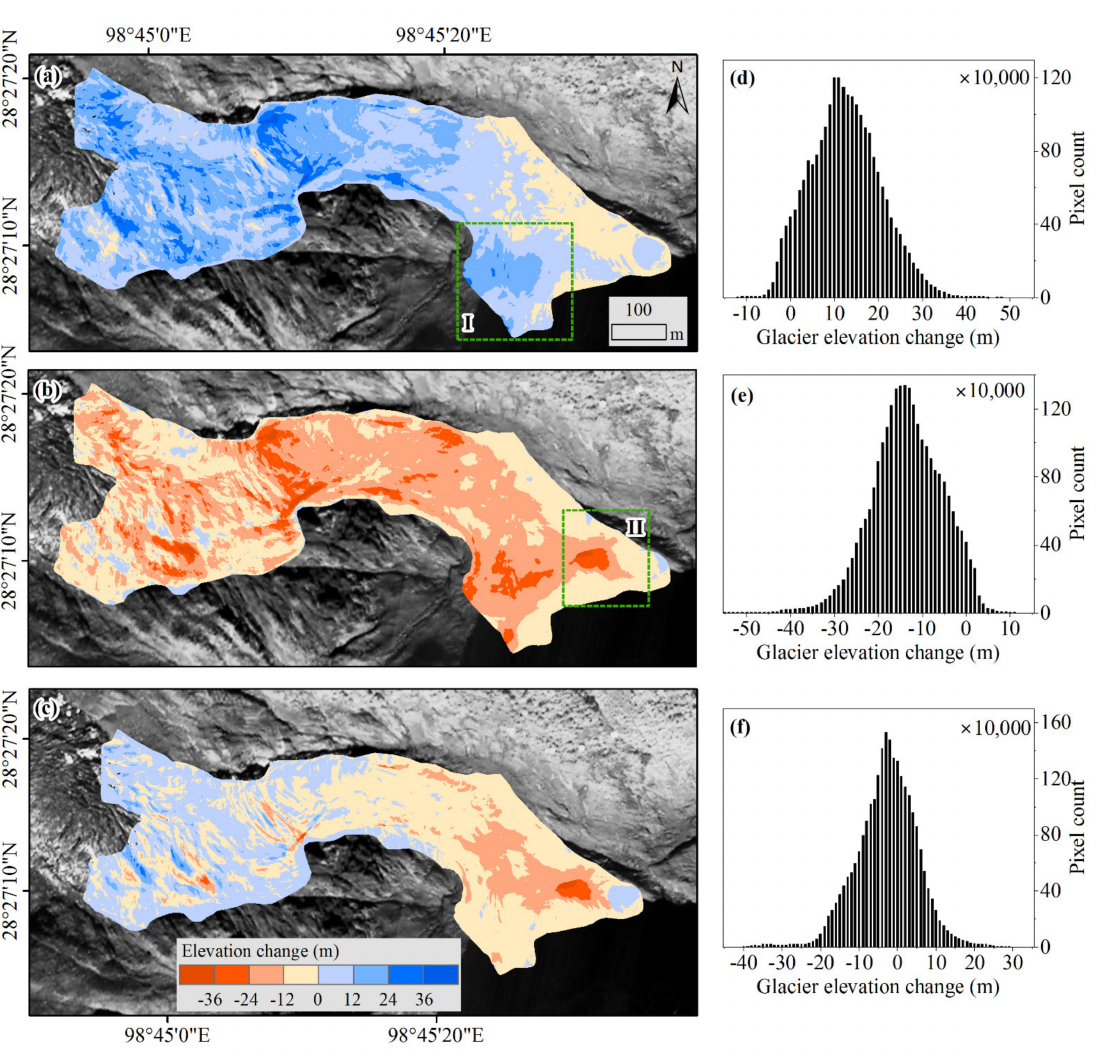
Figure 7. Surface elevation changes between DSMs for the periods ( a ) from November 2019 to April glacier area. ( d – f ) Histograms of surface elevation changes at corresponding surveyed times. Insets I and II in panels ( a , b ) show the extent of Figure